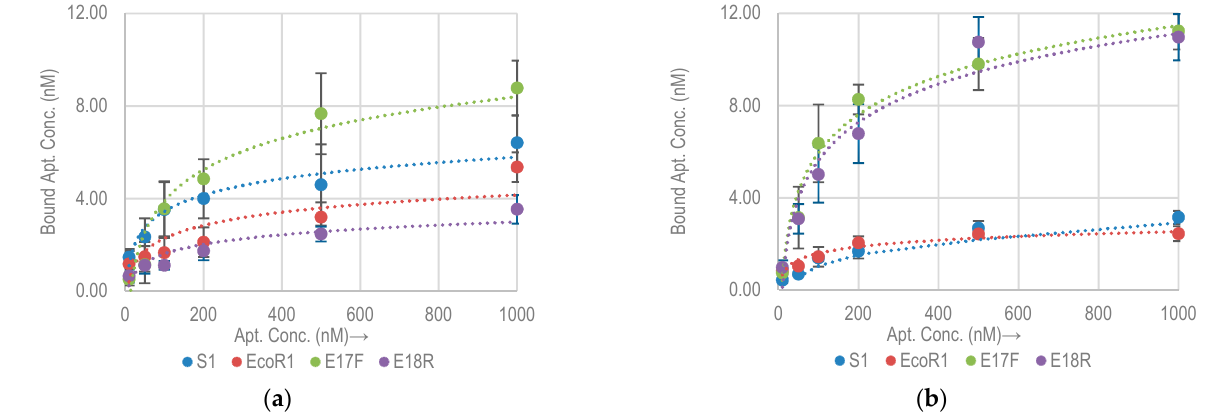
Figure 3. Binding isotherms for four DNA based aptamers with ( a ) E. coli K12 and ( b ) E. coli DH5 α . Table 3. Aptamer binding capacity (B max ) with nonspecific E. coli . Data represent Mean ± SD of 3 independent experiments.